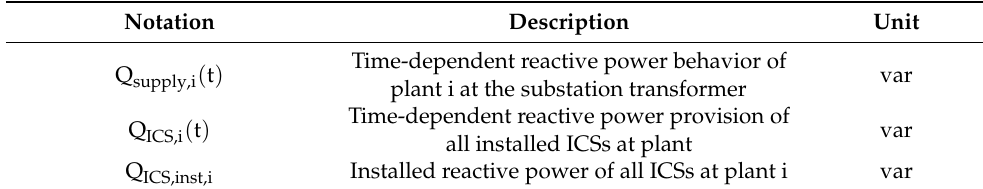
Table 1. Measurement input parameter for reactive power potential